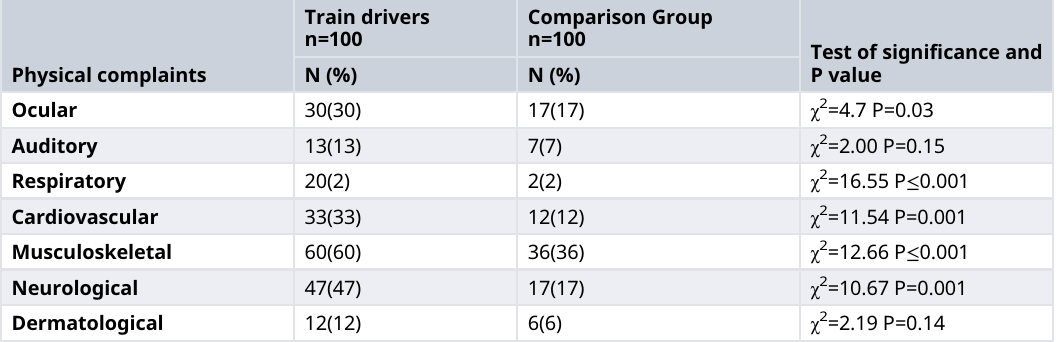
Table 2. Distribution of physical complaints of the study groups in the past 12